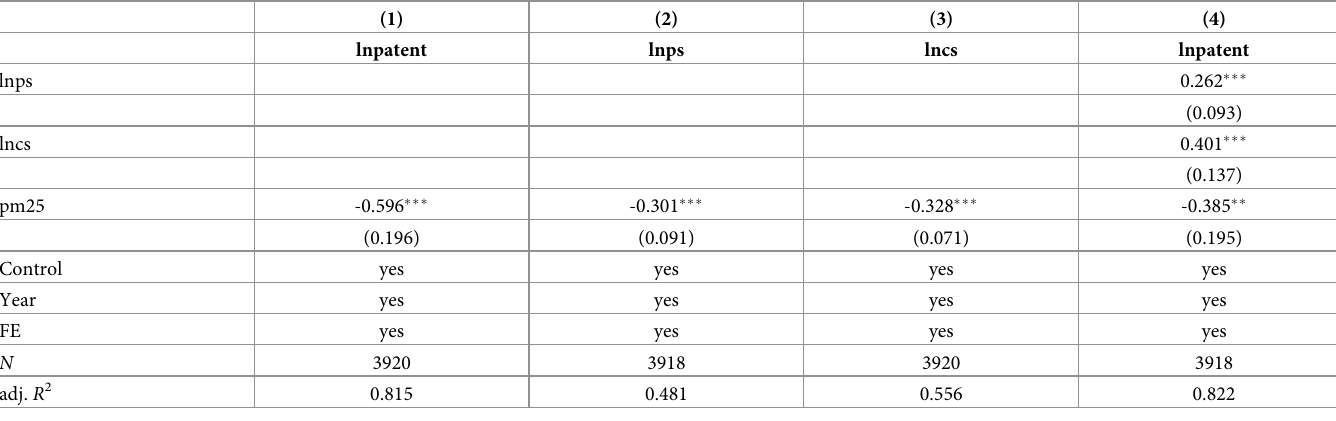
Table 13. Producer services and consumer services.